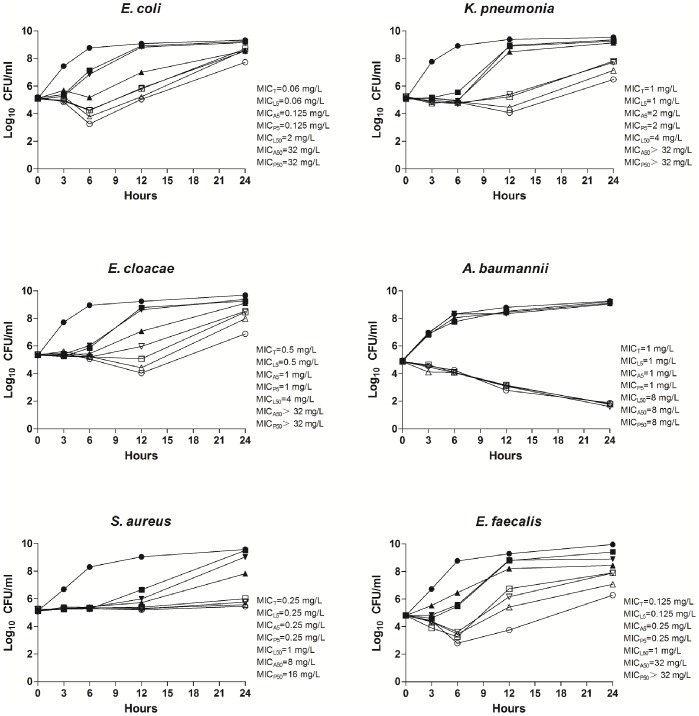
Time–kill curves showing effects of proton pump inhibitors (PPIs) on the activity of tigecycline.MICT, MIC for tigecycline alone; MICL5 and MICL50, MIC for tigecycline in combination with 5 mg/L and 50 mg/L lansoprazole; MICA5 and MICA50, MIC for tigecycline in combination with 5 mg/L and 50 mg/L omeprazole; MICP5 and MICP50, MIC for tigecycline in combination with 5 mg/L and 50 mg/L pantoprazole. •, Control; ▴, 50 mg/L lansoprazole; ▾, 50 mg/L omeprazole; ▪, 50 mg/L pantoprazole; Δ, 5 mg/L lansoprazole; ▽, 5 mg/L omeprazole; □, 5 mg/L pantoprazole; ○, tigecycline alone. The in vitro time-kill experiments were duplicated; mean values are plotted. In all duplicate experiments, similar time-kill results were obtained.